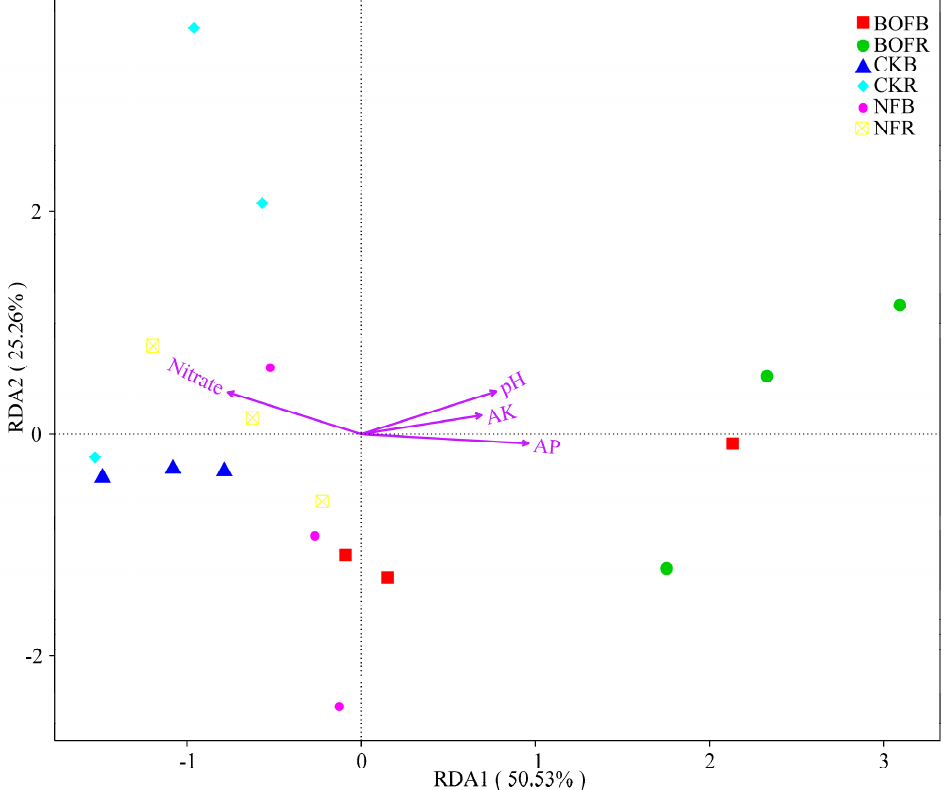
Figure 4. Redundancy analysis of bacterial community structure and soil properties. AP, available phosphorus; AK, available potassium; CKR, rhizosphere of no fertilizer; CKB, bulk of no fertilizer; NFR, rhizosphere of nitrogen fertilizer; NFB, bulk of nitrogen fertilizer; BOFR, rhizosphere of bioorganic fertilizer; BOFB, bulk of bioorganic fertilizer.